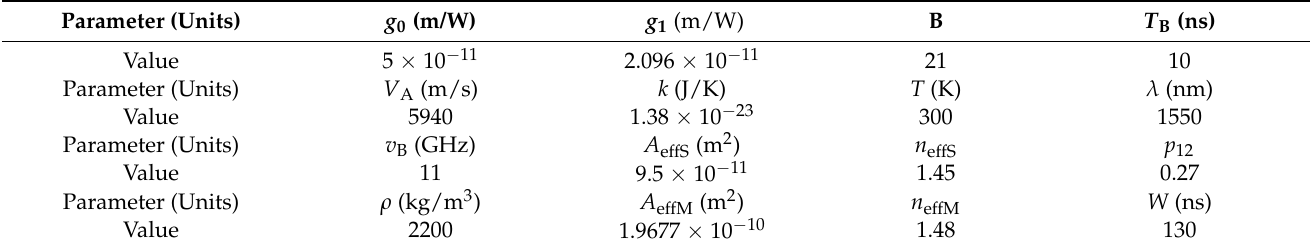
Table 1. Simulation parameters of two sensing